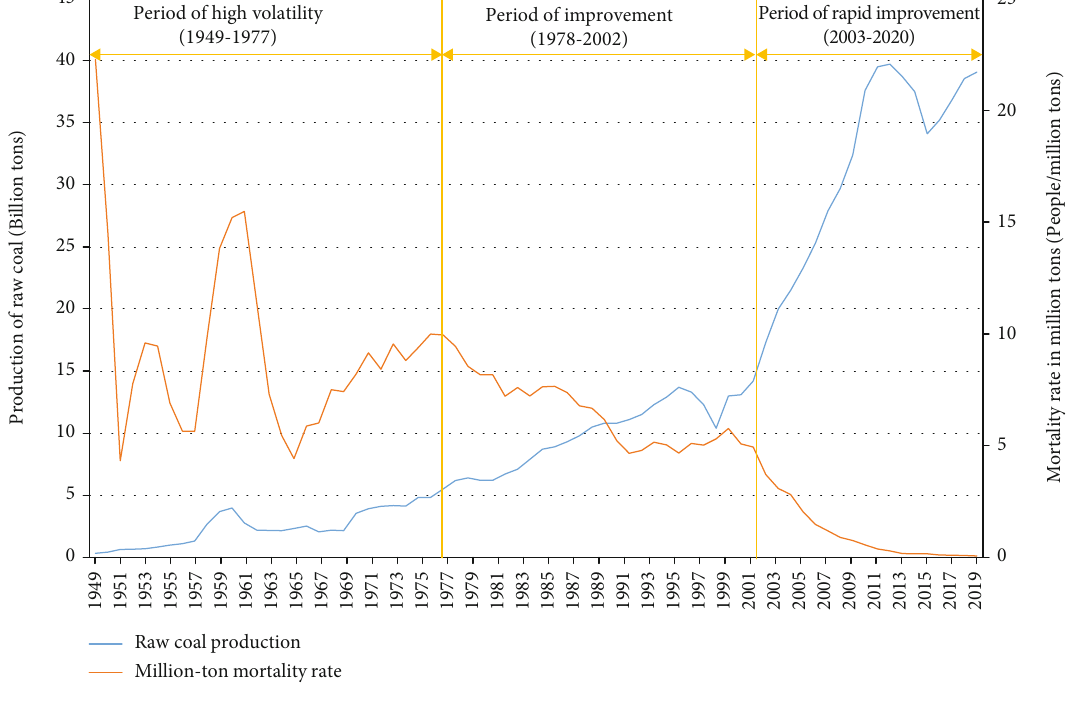
Figure 2: Raw coal production and million-ton mortality rate in China from 1949 to 2020.